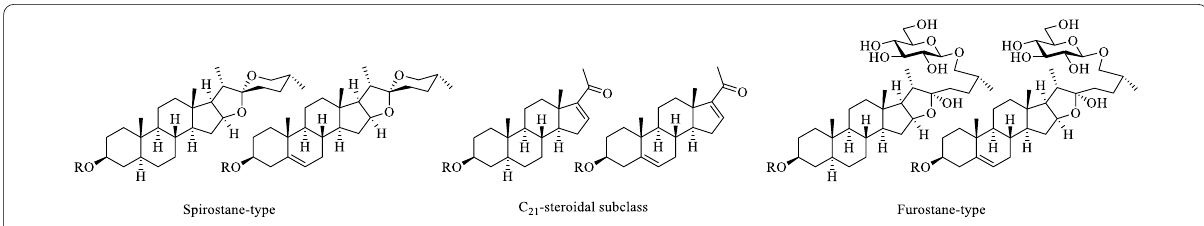
Fig. 8 Sapogenin scaffolds of saponins reported in S. lyratum